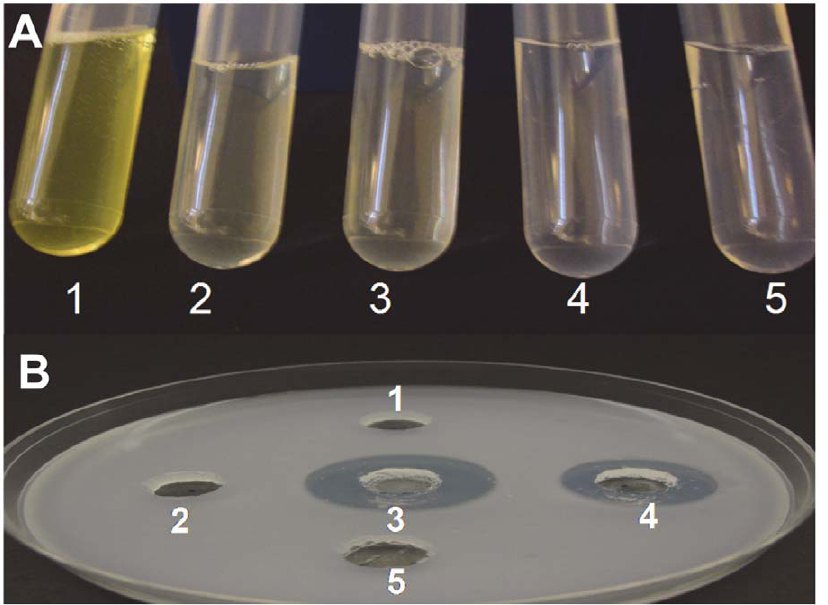
Figure 6. Lipolytic and esterase activity of cutinase. A, para-Nitrophenyl butyrate assay. 1, cp Cutinase; 2, cpSwollenin; 3, Untransformed; 4, E. coli swollenin; 5, Buffer alone; The para-nitrophenyl butyrate (pNPB, 0.01%) was incubated with different extracts for 30 min at 30 u C and visualized. B, Tributyrin plate assay. 1, cpSwollenin; 2, Untransformed; 3, E. coli cutinase; 4, cpCutinase; 5, Buffer alone. Emulsified tributyrin (1%) in 2% agarose was used for plate assay. Different extracts were added to punch holes in plate followed by incubation at 37 u C and visualized after 24